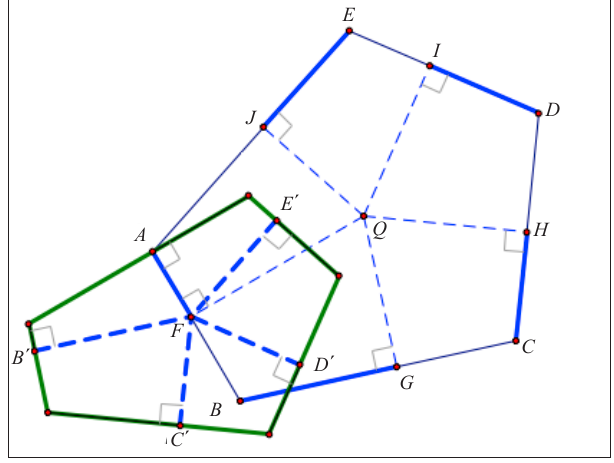
FIGURE 8: An alternative explanation (proof) for an equi-angled